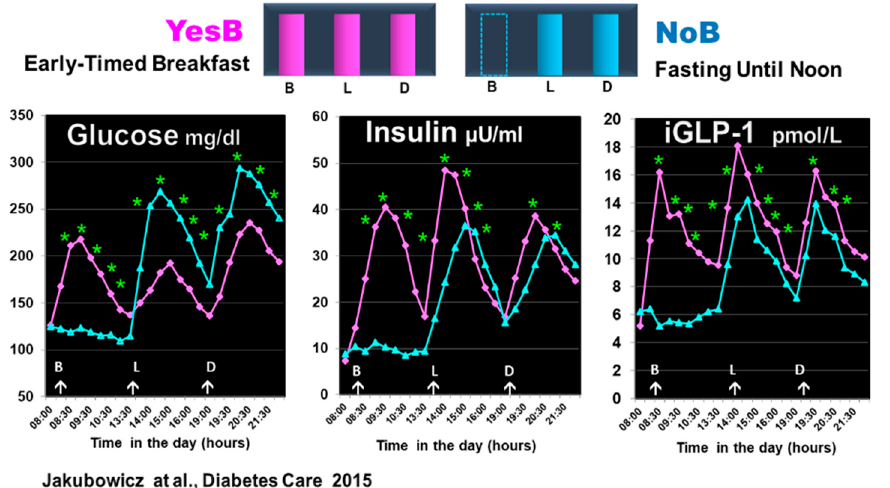
Figure 6. Effect of prolonged fast until noon (NoB) vs. breakfast consumption (YesB) on glucose, insulin, and intact GLP-1 (iGLP-1). The blood samples were taken at fasting and postprandial responses after breakfast or no breakfast, lunch, and dinner at the same time points. Statistics were between the NoB and the YesB. Data are means ± SE. Asterisks denote statistical differences between YesB and NoB at a specific time point. * p < 0.001. B: Breakfast; L: Lunch; D: Dinner. NoB: purple lines; YesB: blue lines “Reproduced and adapted with permission” [44].